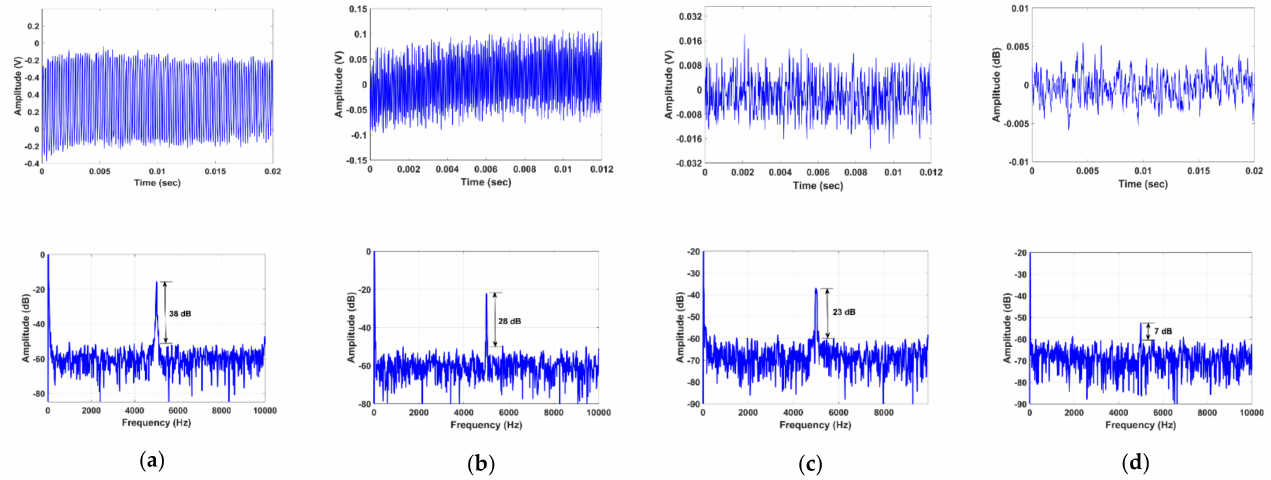
Figure 9. Measured time-domain and frequency-domain spectra of PZT transducer positioned, ( a ) next to the sensor, ( b ) 5 cm, ( c ) 10 cm, and ( d ) 15 cm away from the fiber sensor at a fixed 5 kHz vibrational